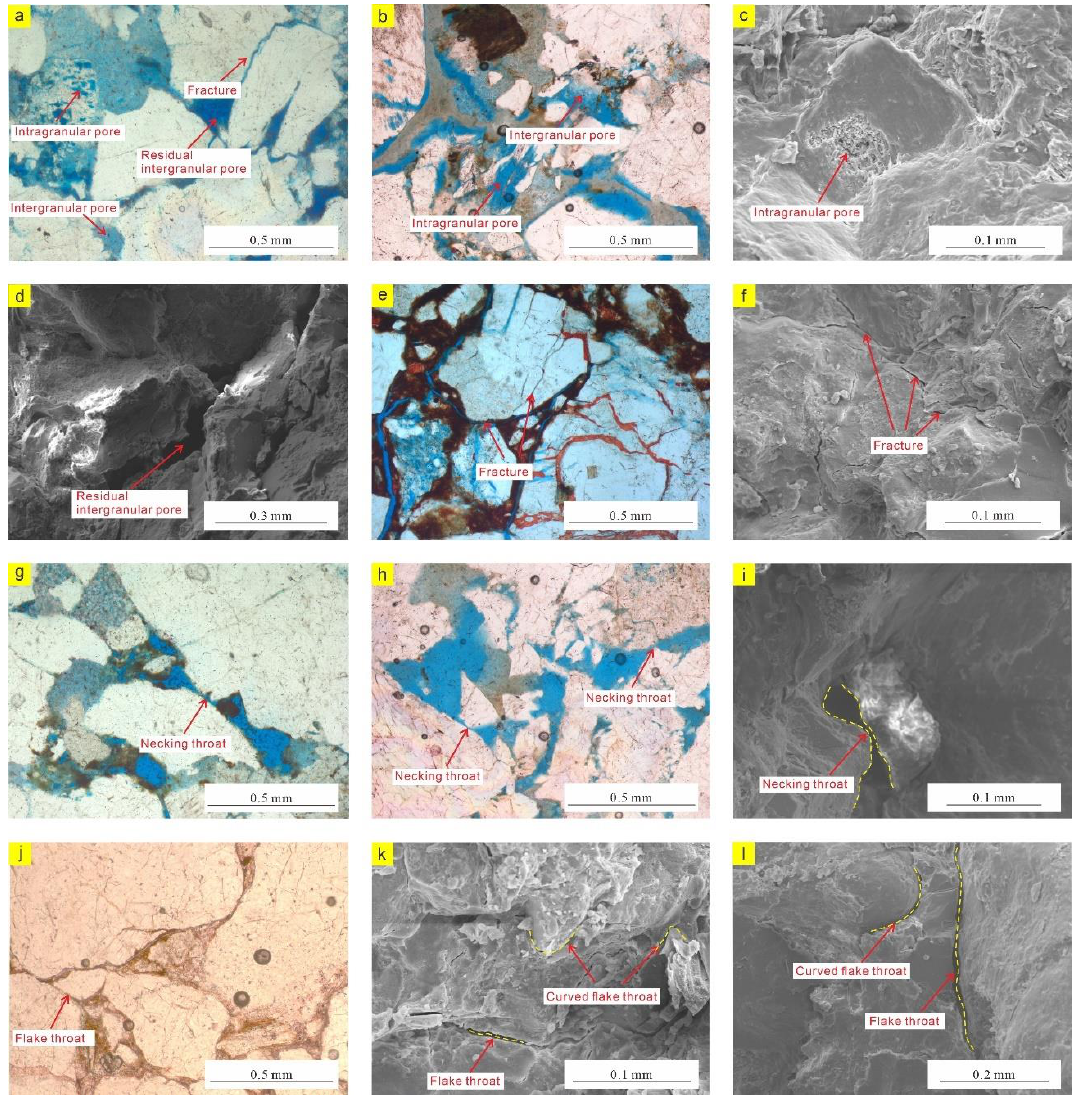
Figure 4. Pore types and pore-throat characteristics in the Niudong area, northern margin of Qaidam Basin: ( a ) N1, 2225.0 m, intragranular pore, intergranular pore, fracture, residual intergranular pore; ( b ) N102, 2120.5 m, intragranular pore, intergranular pore; ( c ) N102, 2113.6 m, intragranular pore; ( d ) N102, 2120.5 m, residual intergranular pore; ( e ) N104, 2054.8 m, fracture; ( f ) N1-2-22, 2149.6 m, fracture; ( g ) N1, 2226.0 m, necking throat; ( h ) N102, 2114.7 m, necking throat; ( i ) N101, 3621.1 m, necking throat; ( j ) N101, 2120.5 m, flake throat; ( k ) N1-2-22, 2149.4 m, flake throat, curved flake throat; ( l ) N101, 3623.2 m, flake throat, curved flake throat.